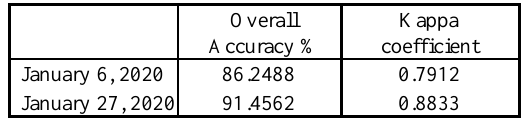
Table 3 . Overall accuracies and Kappa coefficients of the pre-eruption and post-eruption maps